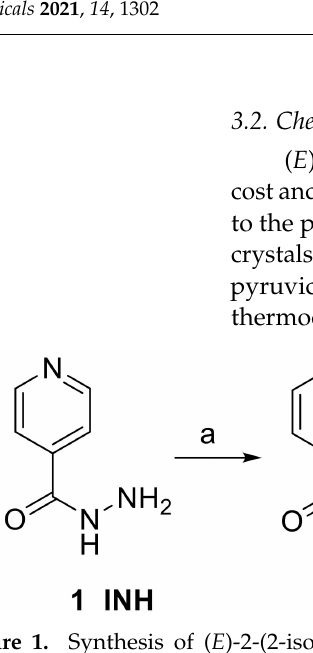
Figure 1. Synthesis of ( E )-2-(2-isonicotinoylhydrazineylidene)propanoic acid esters 3 (reagents and conditions: ( a ) pyruvic acid, MeOH, reflux, 2 h; ( b ) R-OH or R-SH, N -(3-dimethylaminopropyl)- N (cid:48) -ethylcarbodiimide hydrochloride, 4-(dimethylamino)pyridine, CH 2 Cl 2 , 12 h, 0 ◦